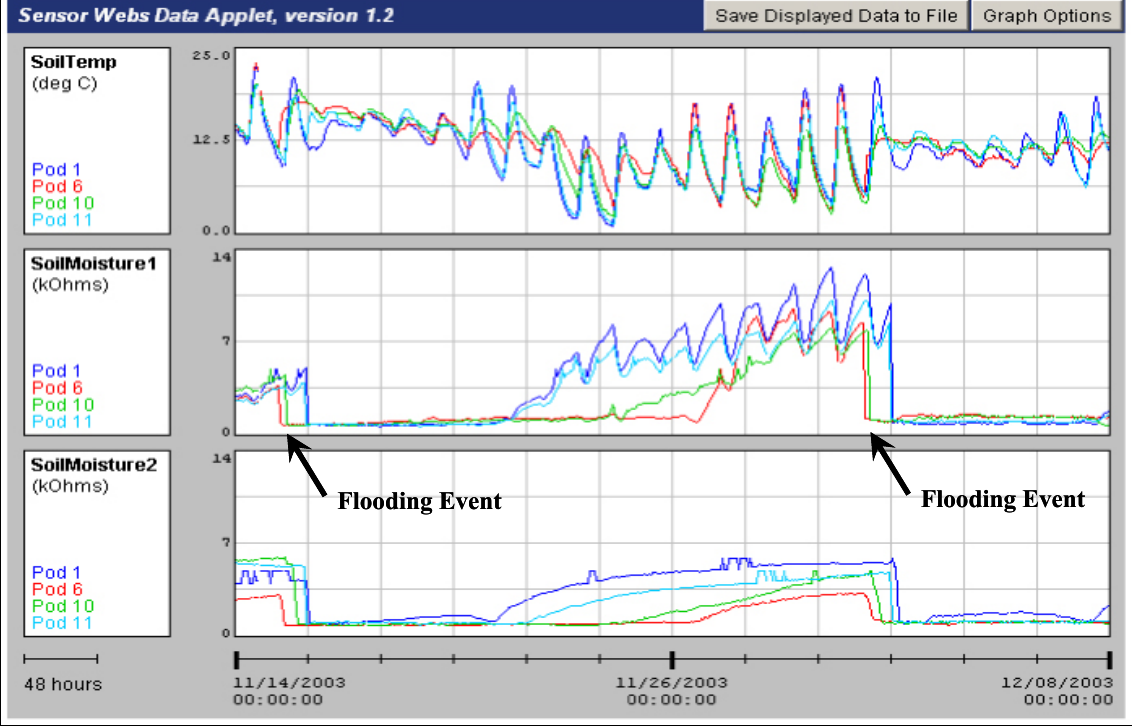
Figure 6. View looking north with recharge basin 102 fully inundated. Pod 11 is clearly visible above the rising water.